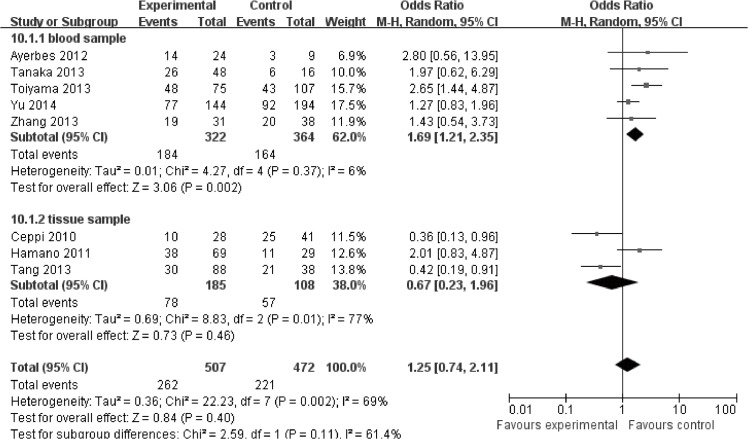
Meta-analysis evaluating miR-200c expression and lymph node metastasis in cancer patients.